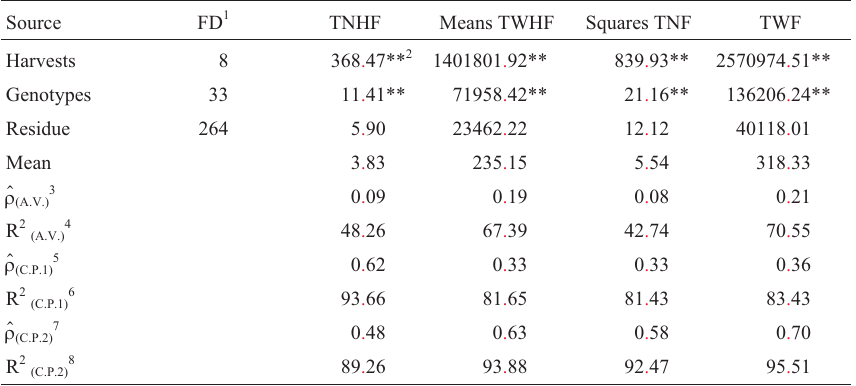
Table 1 - Summary of ANOVA for total number of healthy fruit per plant (TNHF), total weight of healthy fruit per plant (TWHF), total number of fruit (TNF) and total weight of fruit